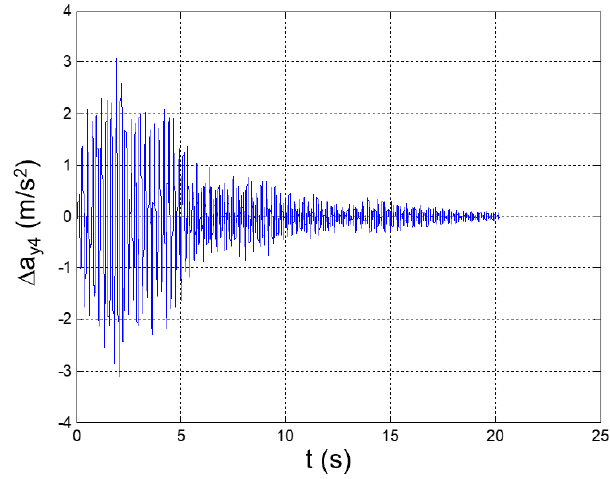
Figure 13. Seismic response, interstory acceleration at the 4th floor ( Δ 𝑎 y4 = 𝑎 y4 − 𝑎 y3 ).